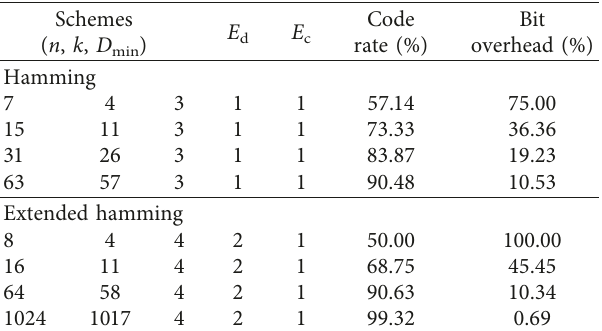
Figure 16: ModelSim simulation of Hamming [16, 11, 4] SECDED capabilities. Table 8: Evaluation of Hamming